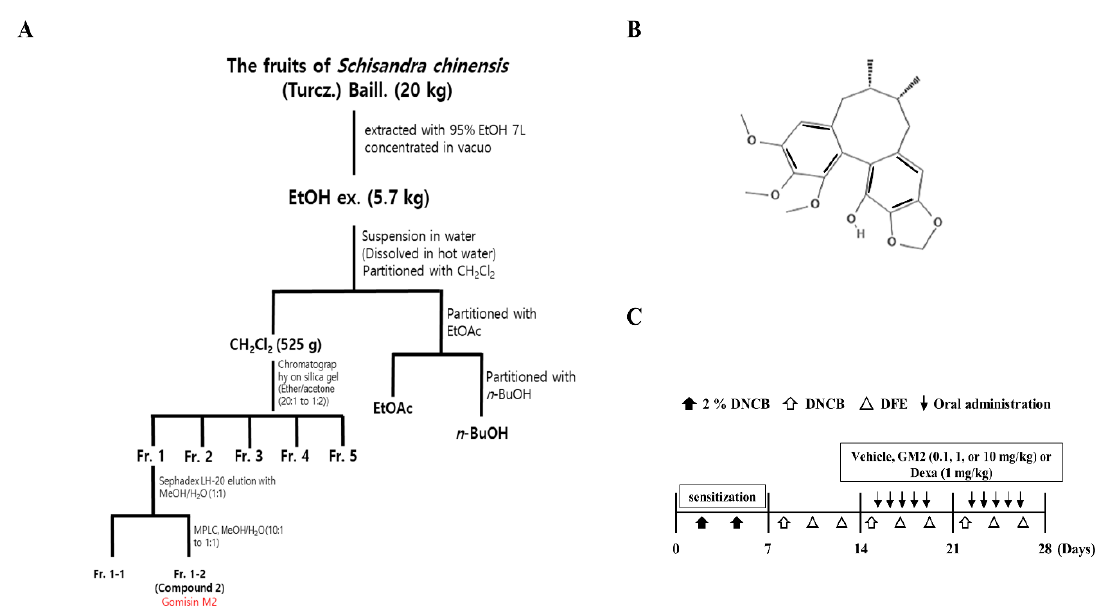
Figure 1. Isolation scheme, structure of GM2, and experimental scheme of AD induction. ( A ) Schematic diagram of GM2 isolation of the bioactive compounds from Schisandra chinensis (Turcz.) Baill. ( Schisandraceae ). ( B ) Chemical structure of GM2. ( C ) Experimental scheme for AD induction to application 2,4-dinitrochlorobenzene (DNCB) and Dermatophagoides farina (DNCB/DFE) and oral administration of gomisin M2 (GM2) or dexamethasone (Dexa).